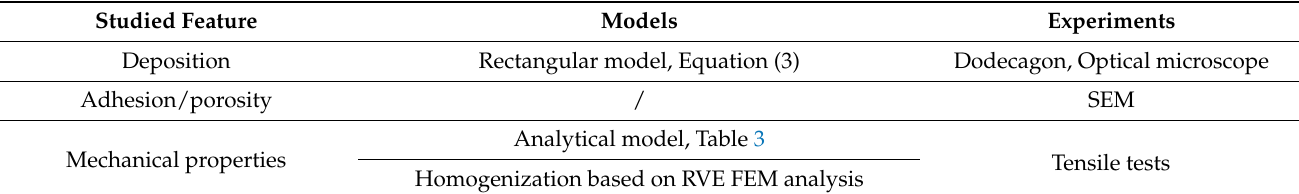
Table 4. Summary of the investigated